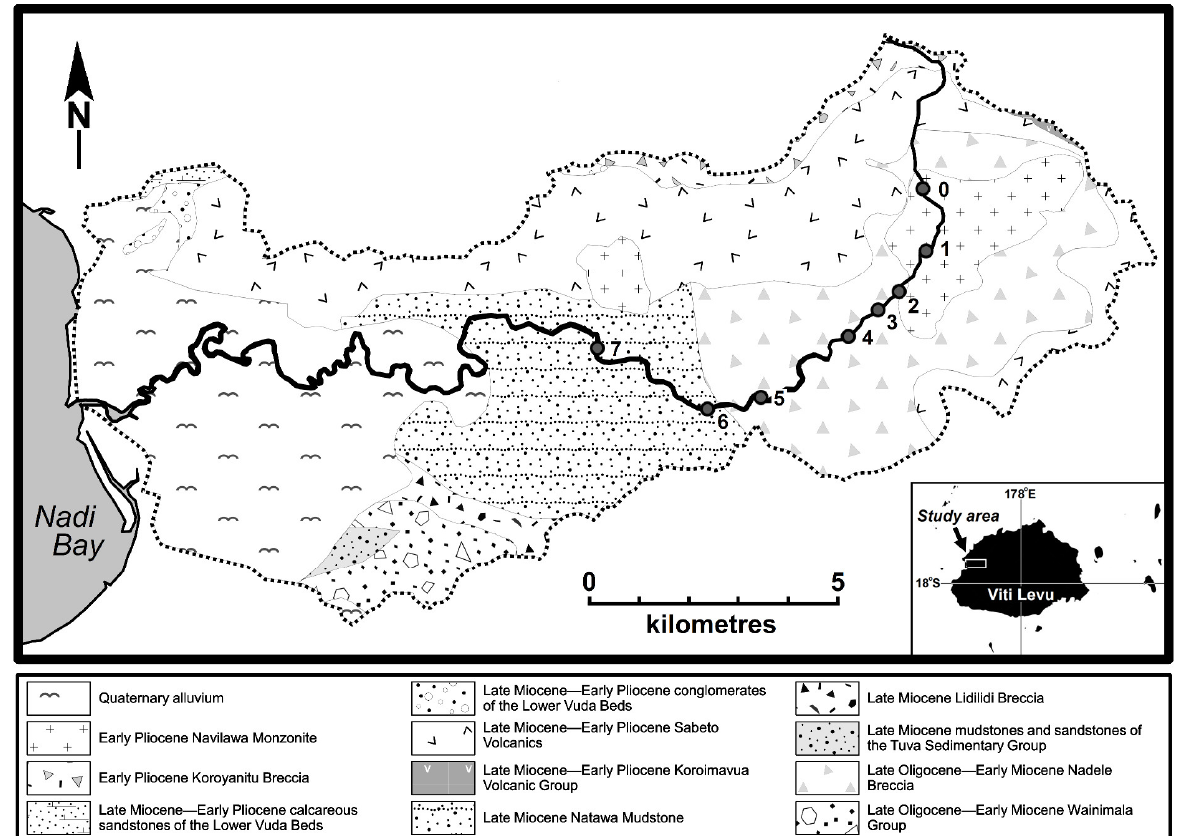
Figure 2. The geology of the catchment of the Sabeto River of western Viti Levu, Fiji, showing the location of the sampling sites. Modified from Gale et al. [32].